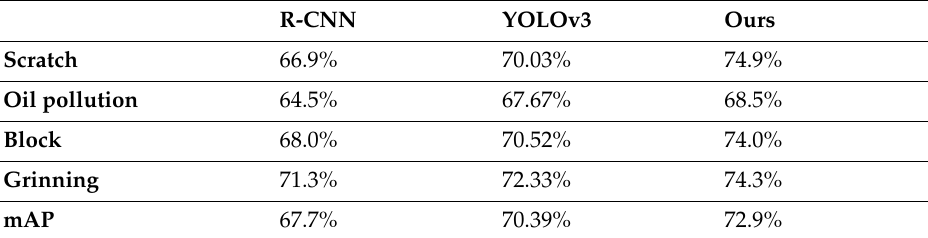
Table 2. Comparison of average precision.